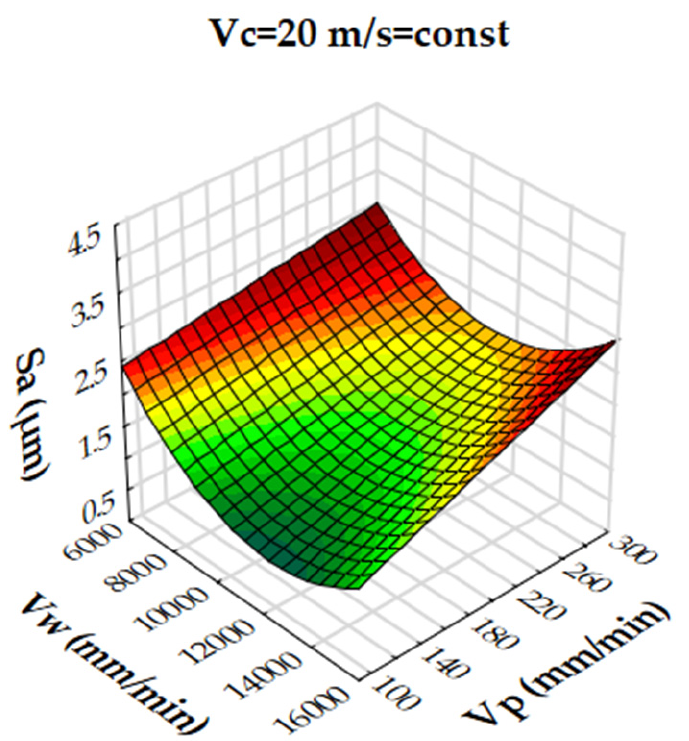
Figure 7. Dependence of roughness, Sa, on longitudinal feed velocity, Vw, and transverse feed ve- locity, Vp, for a multigranular wheel (constant Vc).